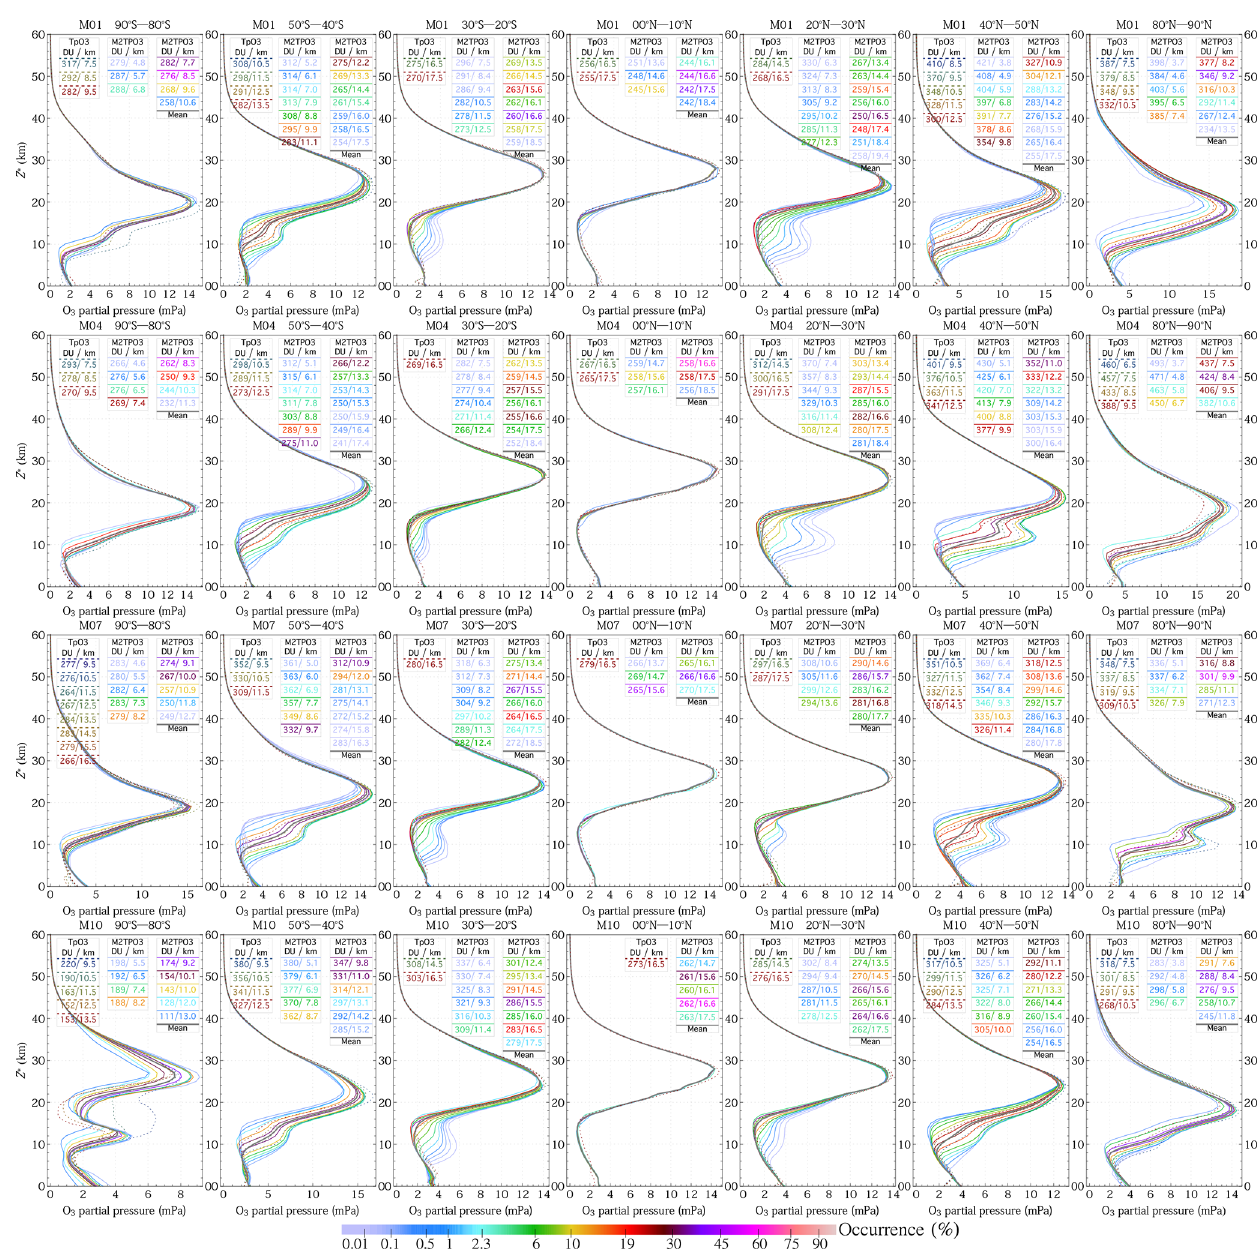
Figure 4. Profile comparisons between M2TPO3 and TPO3 of Sofieva et al. (2014) for four months (January, April, July, and October) and seven latitude zones (90–80 ◦ S, 50–40 ◦ S, 30–20 ◦ S, 00–10 ◦ N, 20–30 ◦ N, 40–50 ◦ N, and 80–90 ◦ N). Colored solid lines represent M2TPO3 profiles, while the dotted ones represent TPO3 profiles. The color of a solid line indicates the percentage occurrence of the profile, which is calculated as the percentage of profiles in the month–latitude class that fall within the Z ∗ tropopause pressure bin. The line legends display the average tropopause altitude and the average total O 3 column for the corresponding climatological profile. The solid gray line represents the downgraded M2TPO3 profile, i.e., the monthly zonal mean